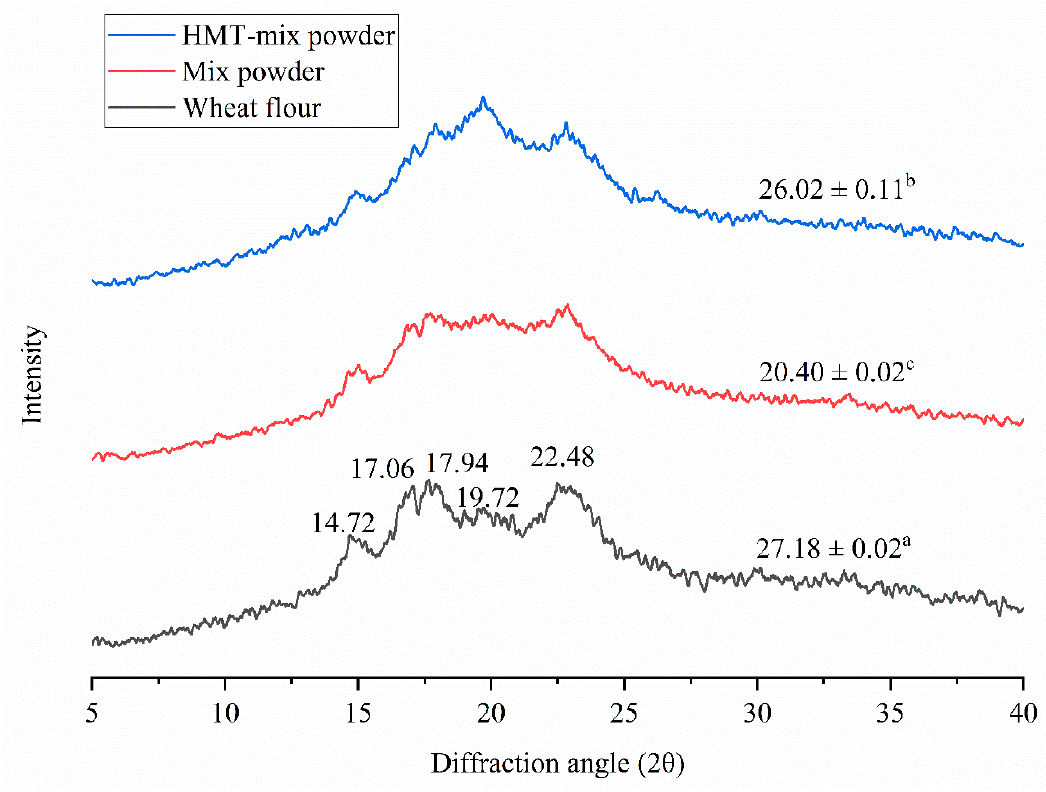
Figure 1. X-ray diffraction patterns of wheat flour, mix powder and HMT-mix powder. Numbers showed in mean ± SD values indicate the relative crystallinity. a–c Means in the same column with different lowercase letters were significantly different